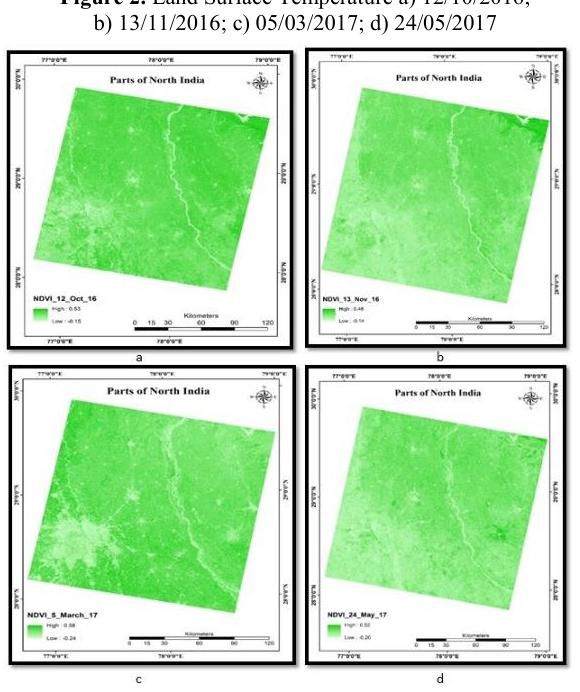
Figure 3. Normalized Difference Vegetation Index a) 12/10/2016; b) 13/11/2016; c) 05/03/2017; d) 24/05/2017 The temporal variation in NDVI within the study area is shown in Figure 3. It has been observed that NDVI and LST are inversely proportional to each other. For the given time period, NDVI value ranges between -0.2 (24 th May, 2007) and 0.58 (5 th March, 2017)